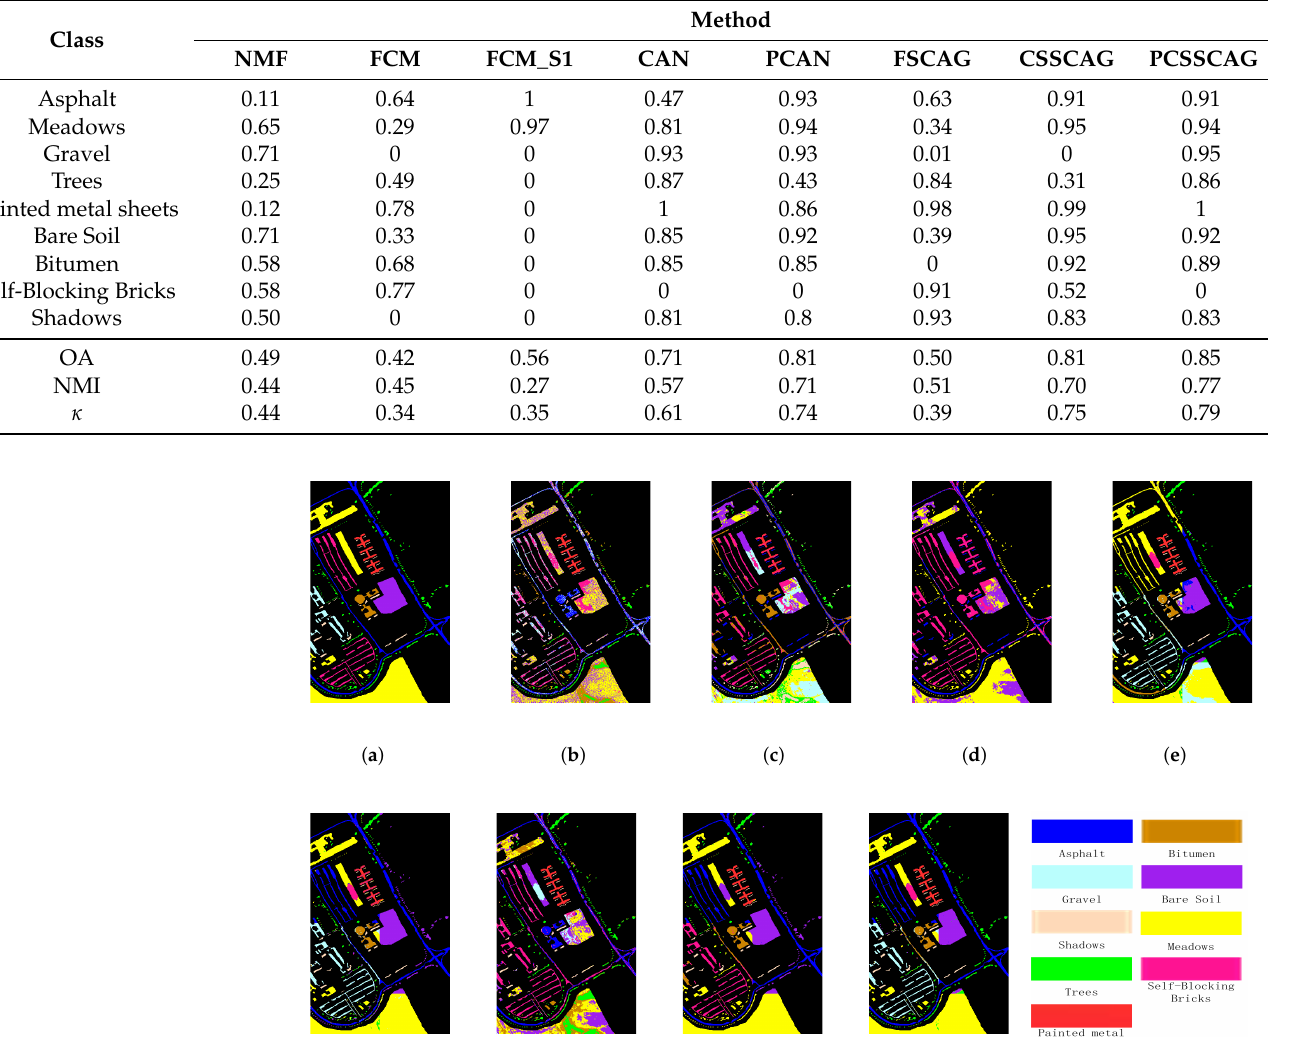
Table 4. Clustering accuracy of each category, OA, NMI, and κ of different clustering methods on the University of Pavia dataset.